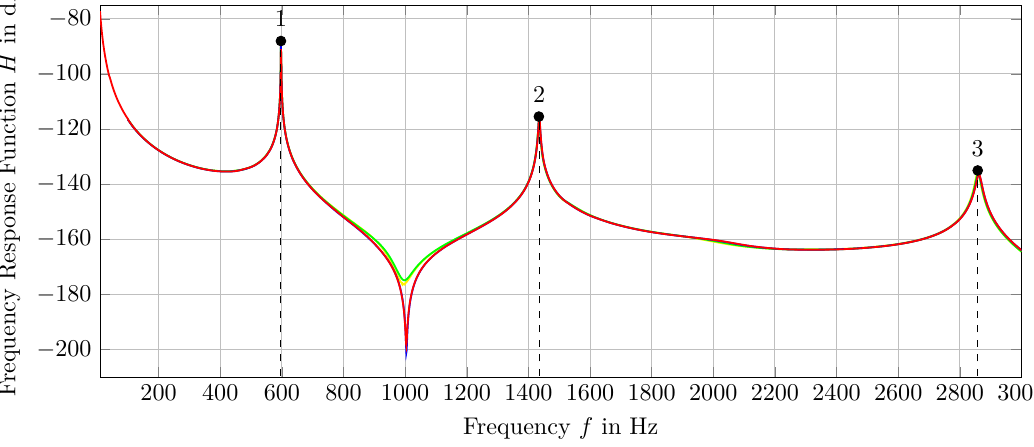
Figure 11. Measured FRF curves of the test